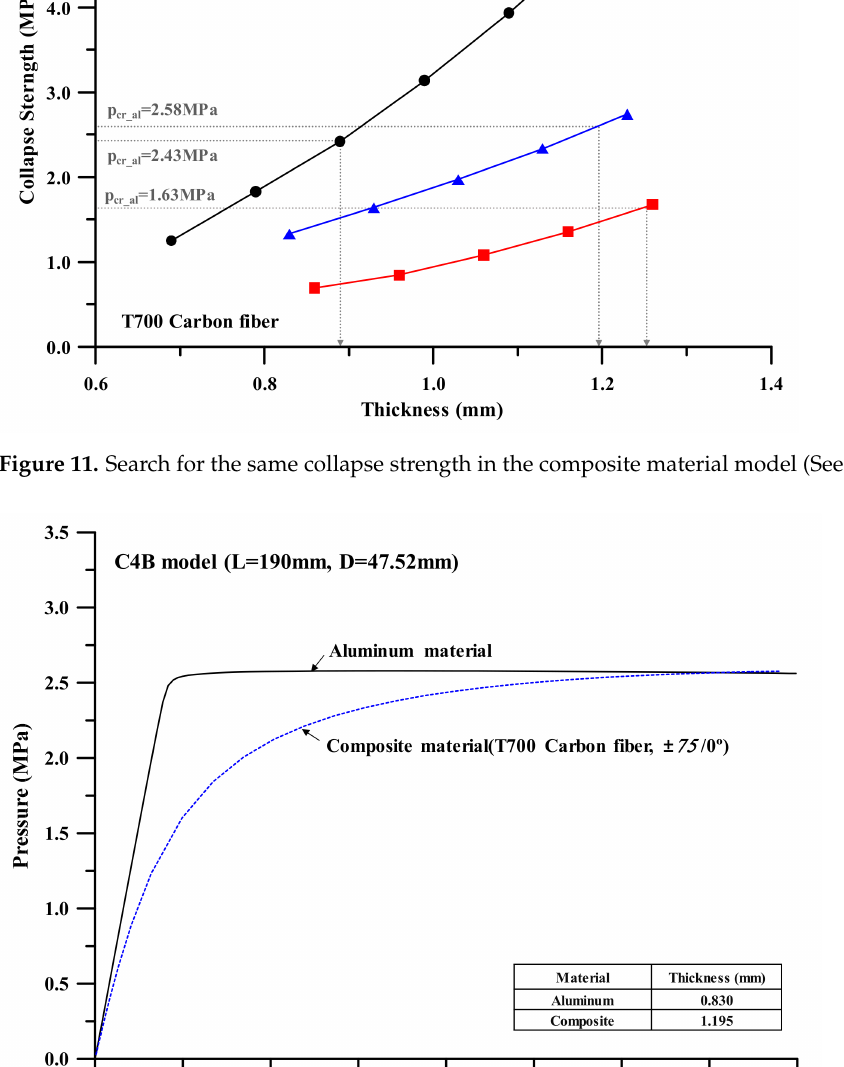
Figure 12. Pressure-average deflection curve for C4B